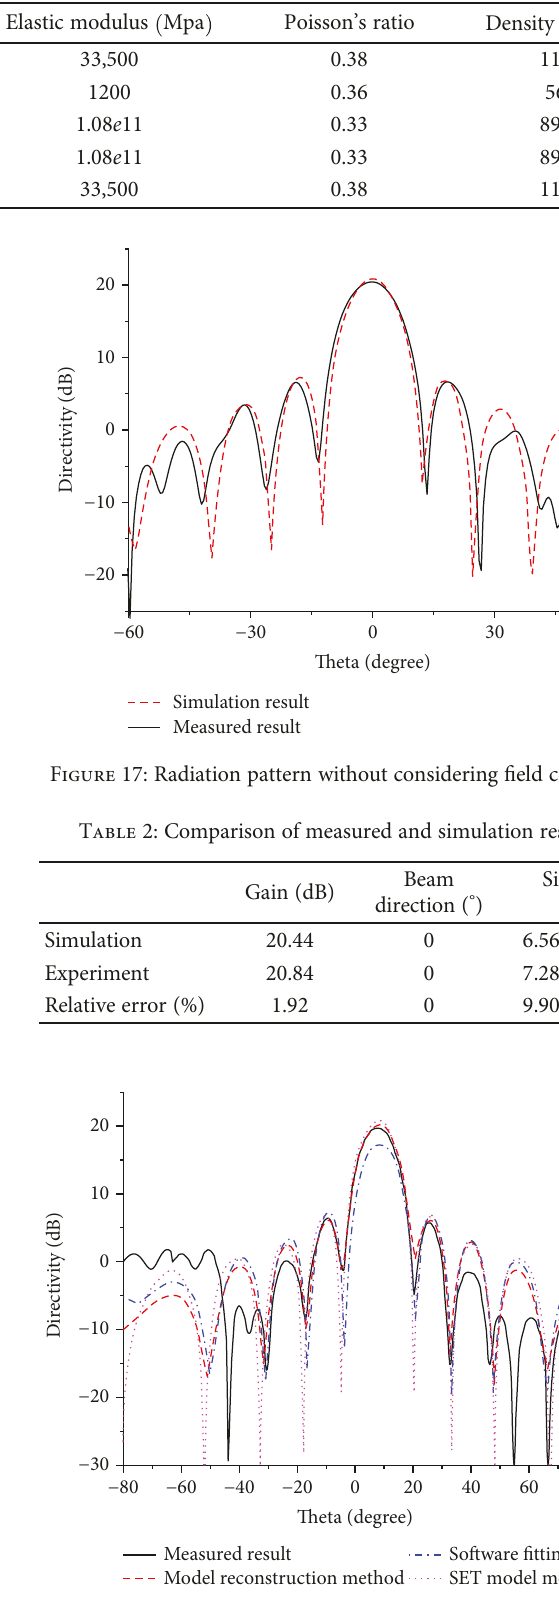
Figure 16: Antenna array model.